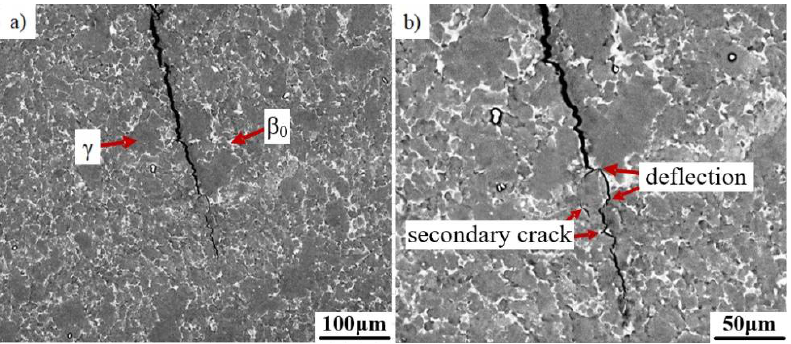
Figure 6. The crack propagation behavior of the as-forged Ti-43Al-2Cr-1.5Mn-0.1Y alloy. ( a ) macro morphology, ( b ) secondary crack and